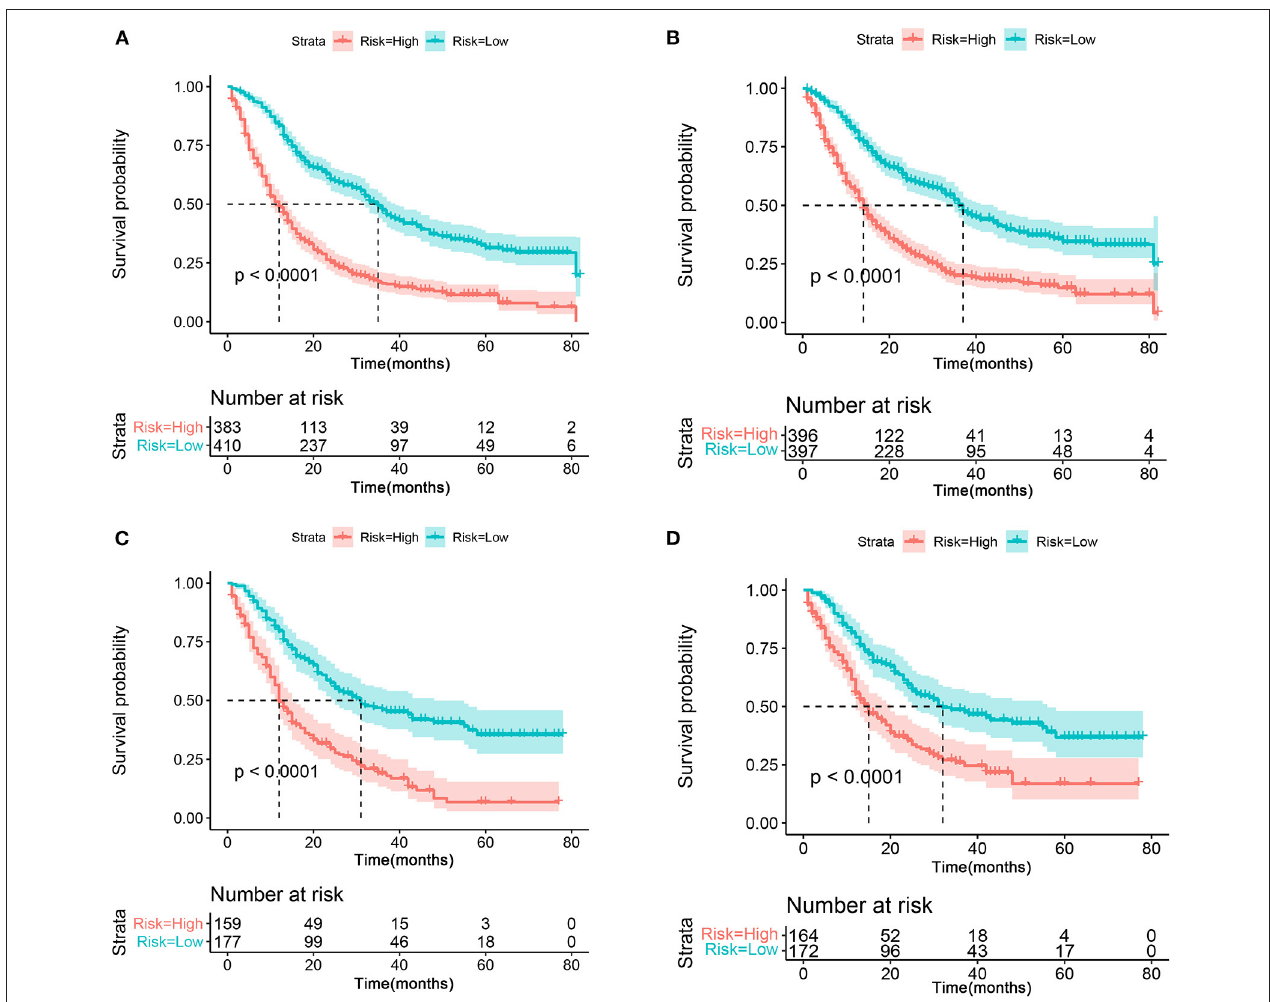
FIGURE 9 | The Kaplan–Meier survival curve of risk group stratification for OS (A) and CSS (B) in the training cohort. The Kaplan–Meier survival curve of risk group stratification for OS (C) and CSS (D) in the validation cohort.